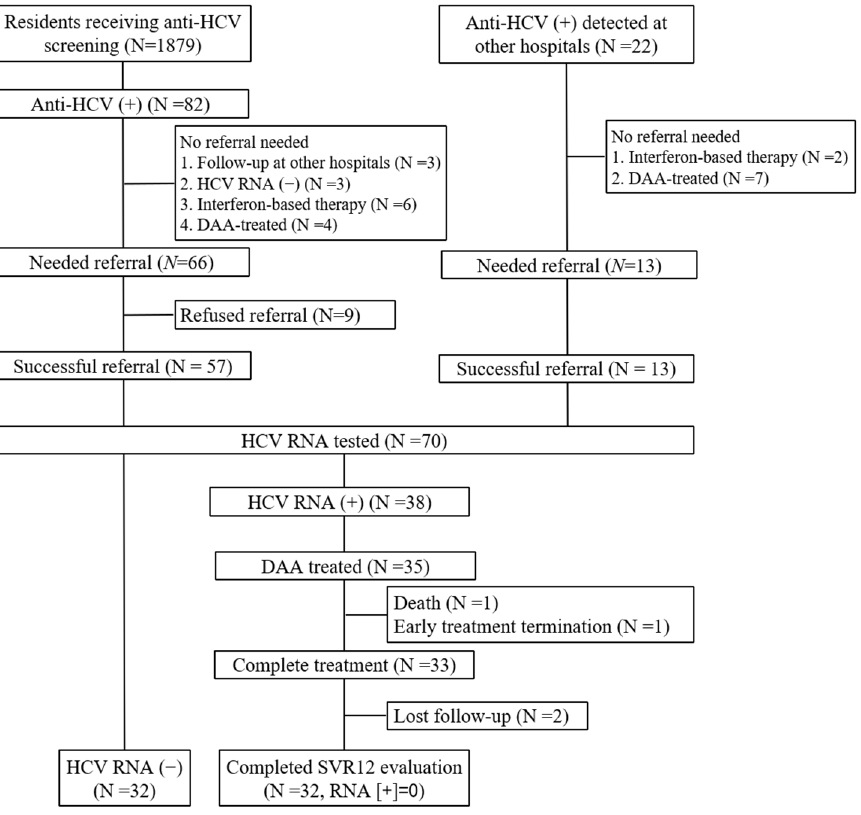
Figure 2. Flowchart of participants in the referral model. DAA, direct-acting antiviral; SVR, sustained virological response.